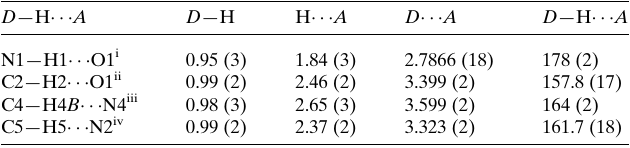
Table 1 Hydrogen-bond geometry (A˚ , (cid:2) ).